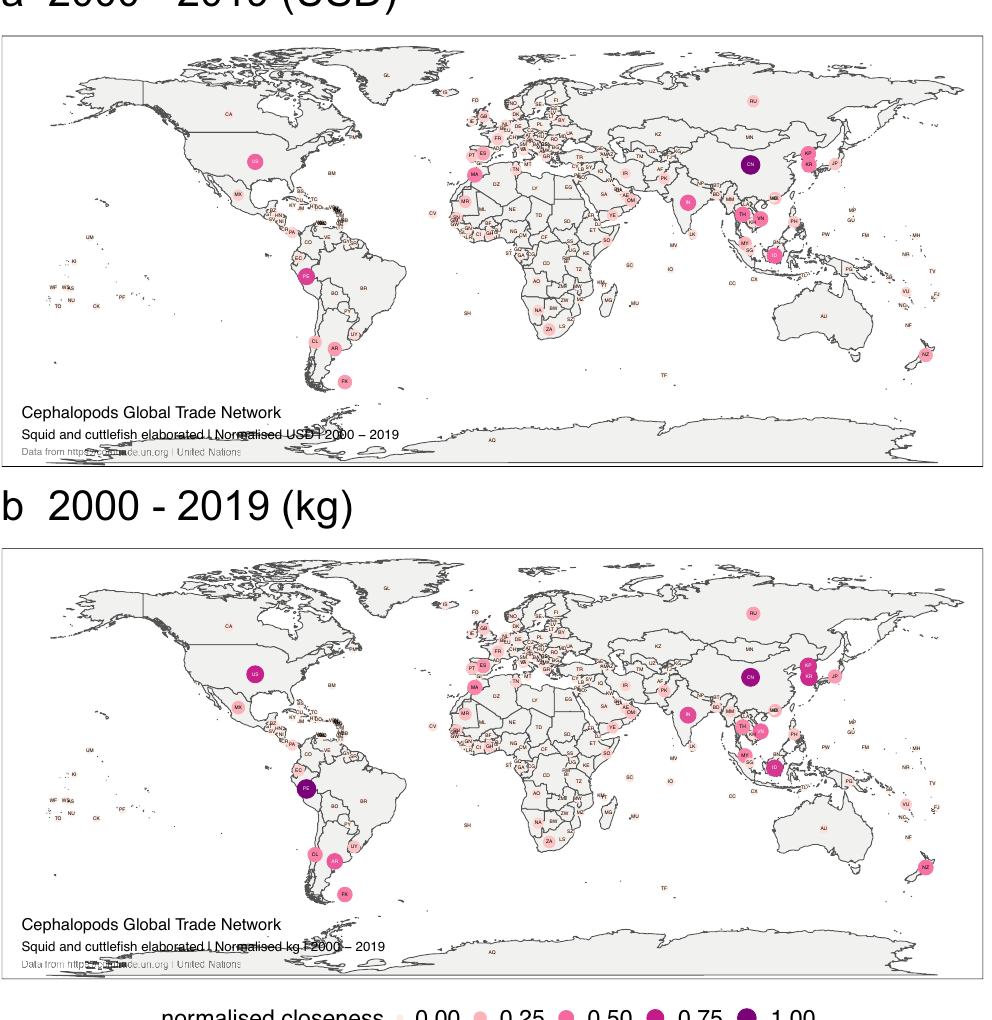
Figure 8. Global trade network for squid and cuttlefish elaborated between 1 January 2000, and 31 December 2019 in monetary value (USD) above, and volume (kg) below. The numbers correspond to the normalised closeness for the monetary value (USD) and volume (kg) traded, respectively. Each node represents a trader. The size and colour of the node represent the relative importance of the trader in the network in terms of its closeness. The figure was created with R 12 (https:// cran.r- proje ct. org) packages: “ggplot2” v.3.2.1 13 (https:// ggplo t2. tidyv erse. org), “ggmap” v.3.0.0 29 (https:// github. com/ dkahle/ ggmap) and “ggraph” v.2.0.0 30 (https:// ggraph. data- imagi nist.